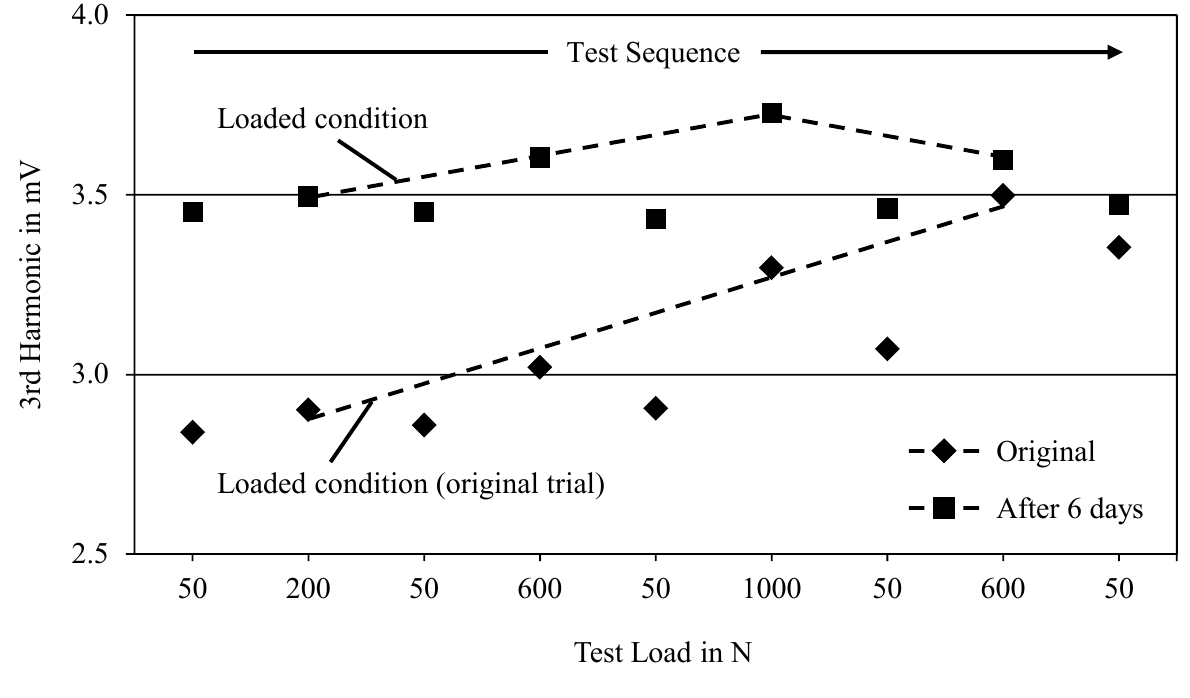
Figure 3. Amplitudes of the 3rd harmonic of Mg96Co4 measured in loading tests which were performed twice on the same tensile specimen with a time interval of 6 days; eddy current ring sensor Ø 10 mm, test frequency 1.6